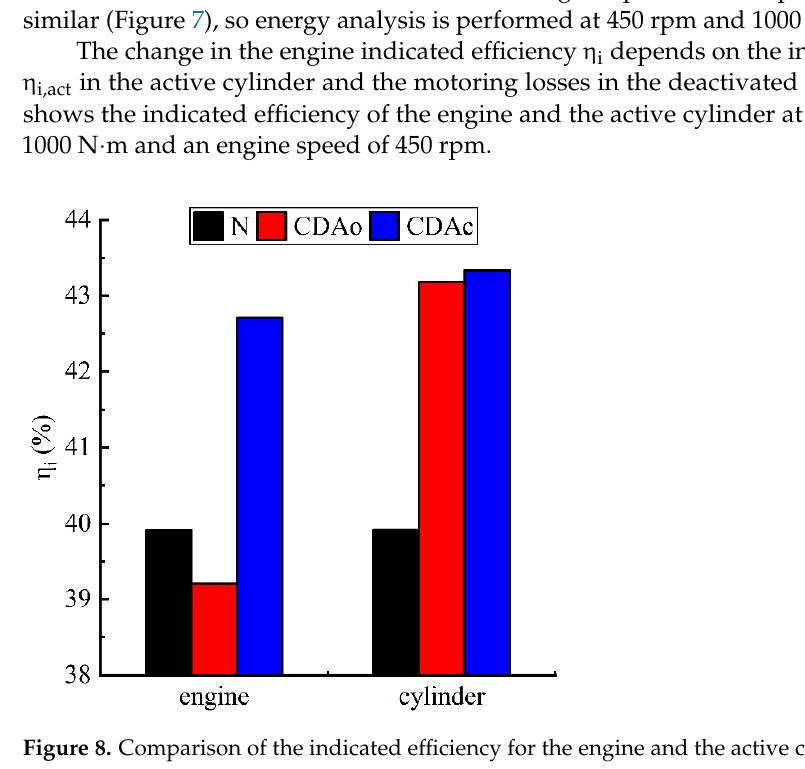
Figure 8. Comparison of the indicated efficiency for the engine and the active cylinder at an engine speed of 450 rpm and an engine load of 1000 N ∙ m (the calculated results were obtained from 1D simulation of GT-SUITE).